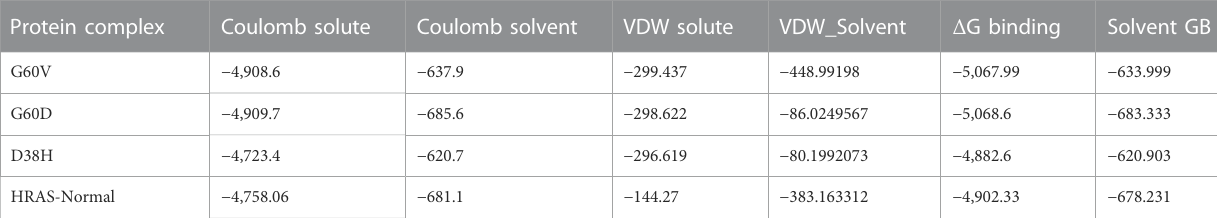
TABLE 3 Summary of the calculated binding free energies utilizing the MM/GBSA algorithm. Protein